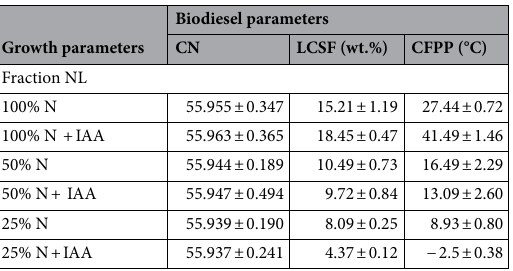
Table 3. Estimated properties of biodiesel: cetane number (CN), long chain saturated factor assessment (LCSF), cold-filter plugging point (CFPP). The values are presented as means ± standard deviation (SD) (n =